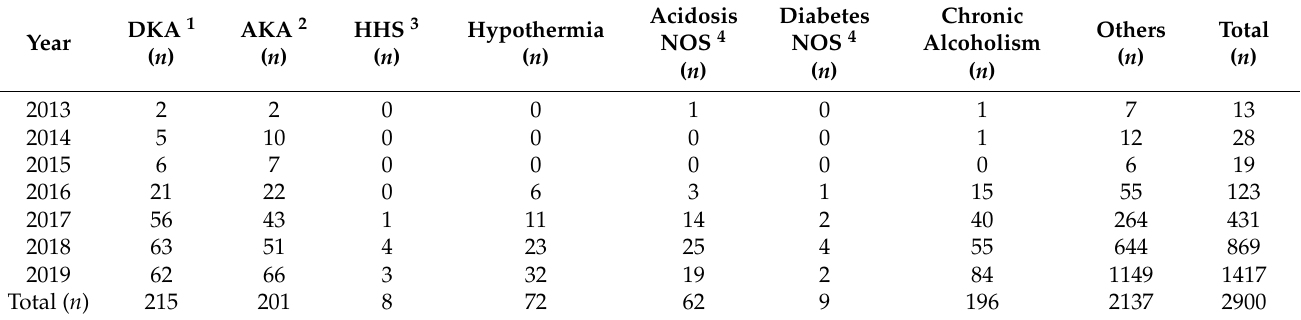
Table 1. All cases analysed for BHB per year.